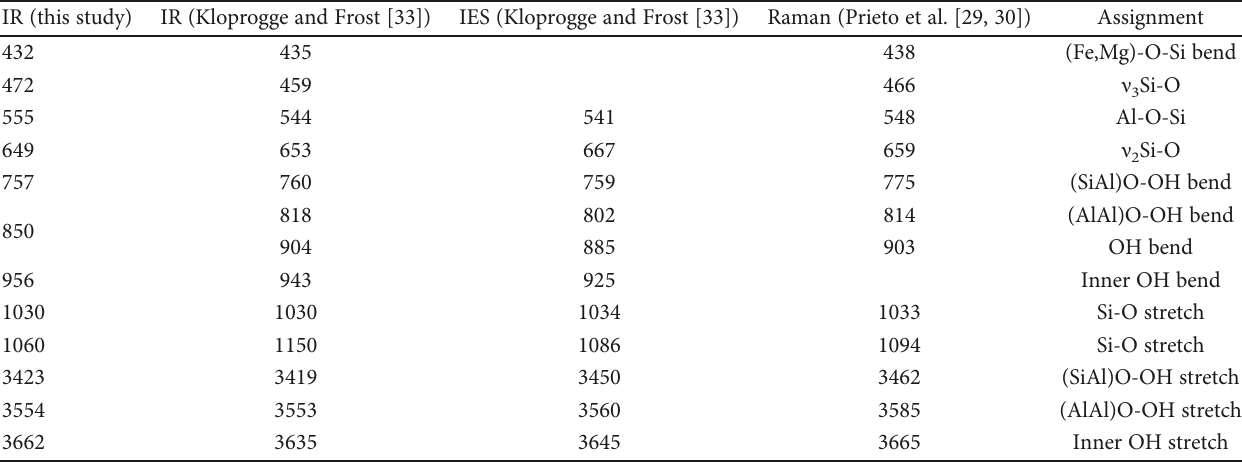
Table 3: Comparison of the infrared spectra used in this study with IR, IES (infrared emission spectra), and Raman spectra from other chlorite studies.